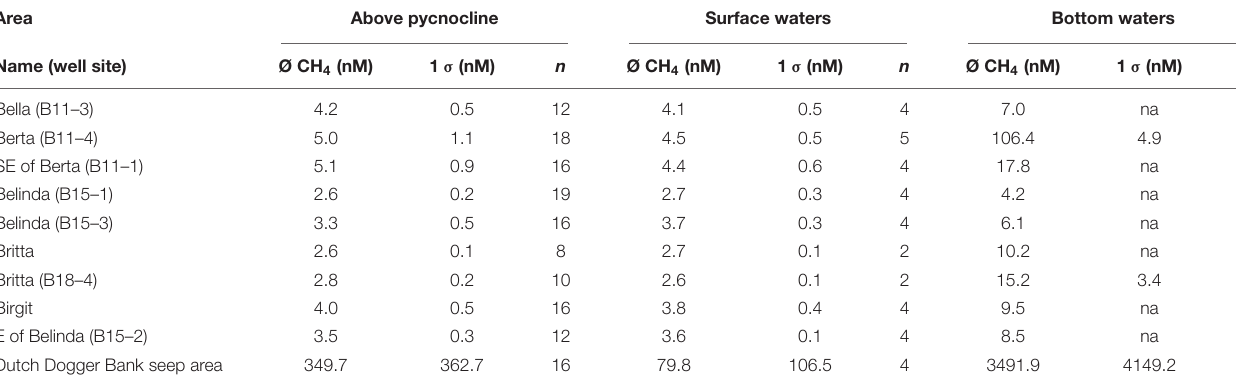
TABLE 1 | Mean values of dissolved methane in the studied areas and in the water column zones. Area Above pycnocline Surface waters Bottom